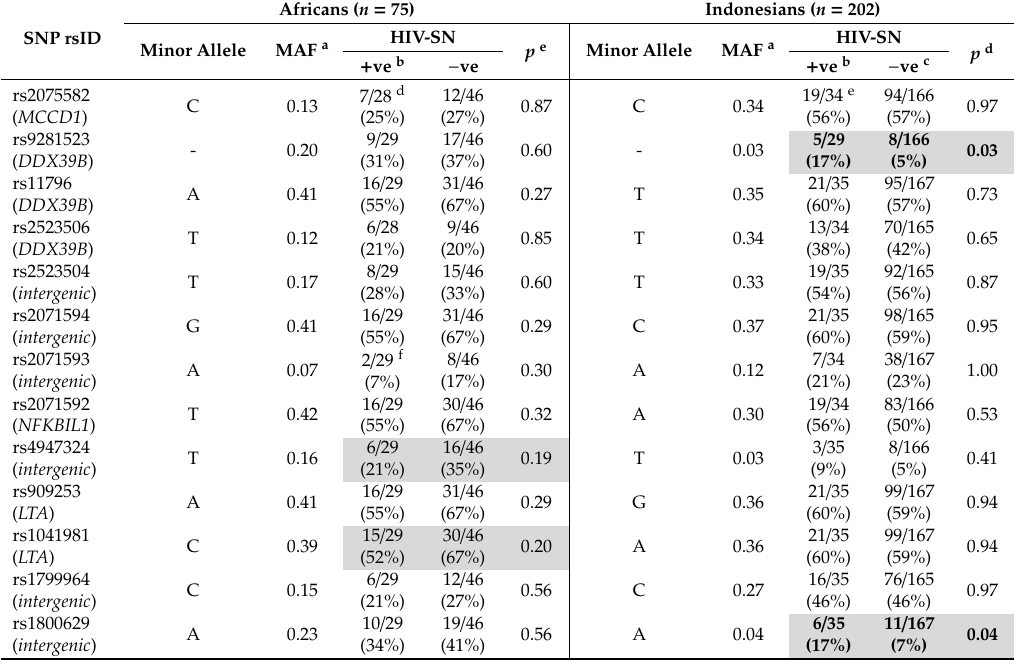
Table 2. Alleles of two SNP associate with HIV-SN in Indonesians but not